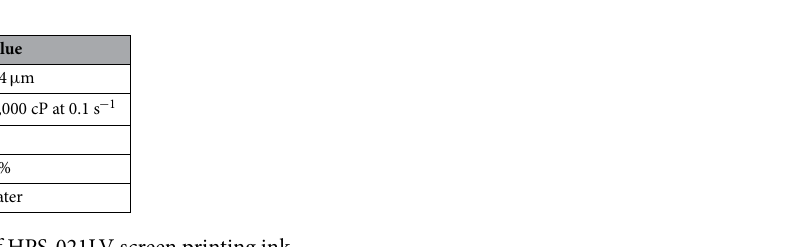
Table 5. Properties of HPS-021LV screen printing